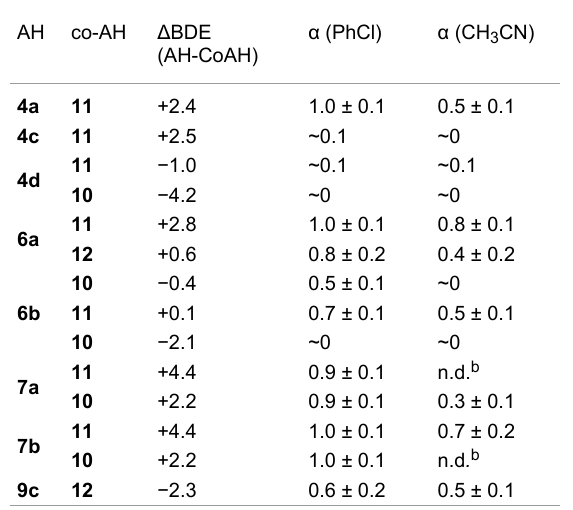
Table 3: Regeneration efficiency ( α ) of a principal antioxidant (AH) by a co-antioxidant (co-AH) in the inhibited autoxidation of styrene in chlorobenzene or acetonitrile (50% v/v) at 303 K. a